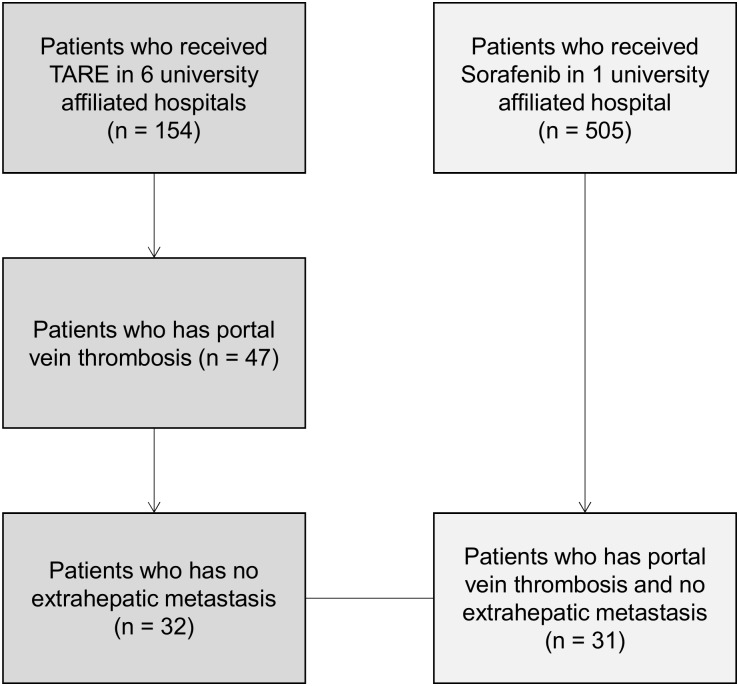
Patient selection.